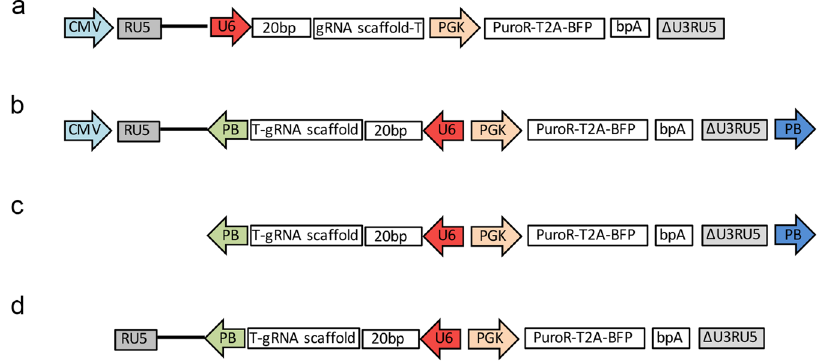
Figure 1. Lentiviral plasmid used in construction of the sgRNA library. ( a ) Schematic of original lentiviral construct pKLV-U6gRNA( Bbs I)-PGKpuro2ABFP described by Yusa et al . 11 . ( b ) Schematic of lentiviral construct Lenti-PB (pKLV-PB-U6gRNA( Bbs I)-PGKpuro2ABFP) used in the sgRNA library generation where the U6 promoter initiates sgRNA transcription on the opposite strand. PiggyBac LTRs were also added flanking the U6-gRNA-PGKpuro-2A-BFP cassette. ( c ) Schematic of PB transposon integrated U6-gRNA-PGKpuro-2A- BFP cassette. ( d ) Schematic of lentivirus integrated U6-gRNA-PGKpuro-2A-BFP